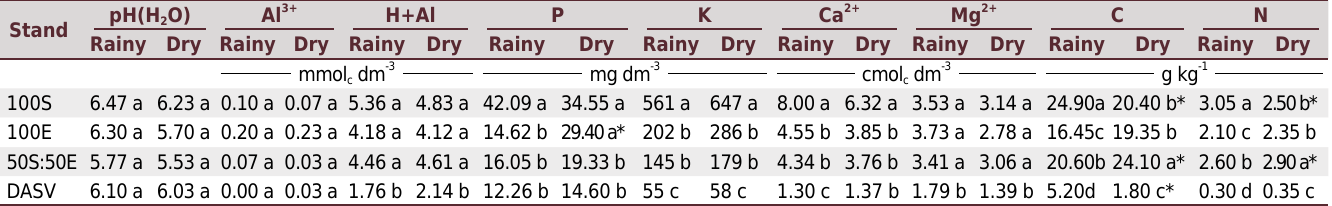
Means followed by the same letter in the same column do not differ statistically in the Scott Knott test at 5 % probability. * : difference between seasons (rainy and dry) for each treatment by Scott Knott test at 5 %